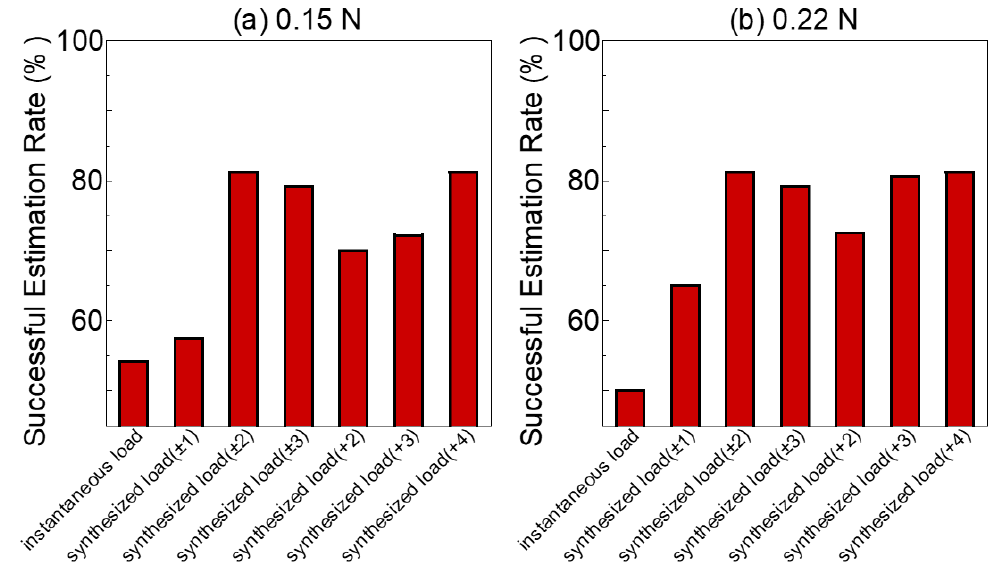
Figure 9. The successful estimation rate of the active load-sensing scheme with different sequence lengths ( a ) 0.15 N ( b ) 0.22 N. Table 1. The mean and variance of different exploration sequences with true load 0.15 N.